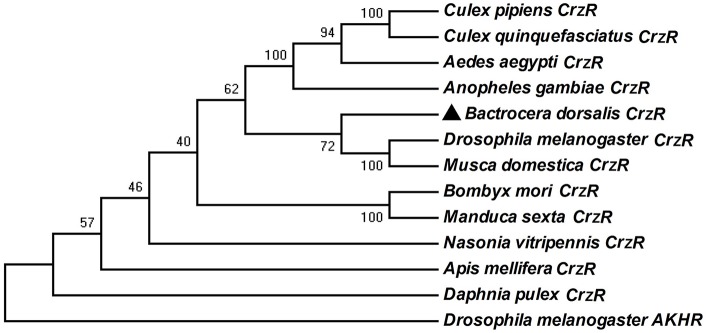
Phylogenetic analysis of BdCrzR and its related G protein-coupled receptors. The tree was constructed with MEGA 6.0 using the neighbor-joining method. Bootstrap support values (1,000 replicates) are indicated on branches. The scale bar represents the number of substitutions per site. BdCrzR was assigned with “▲.” GenBank accession numbers and aa sequences of the GPCRs are given in Figure S2.